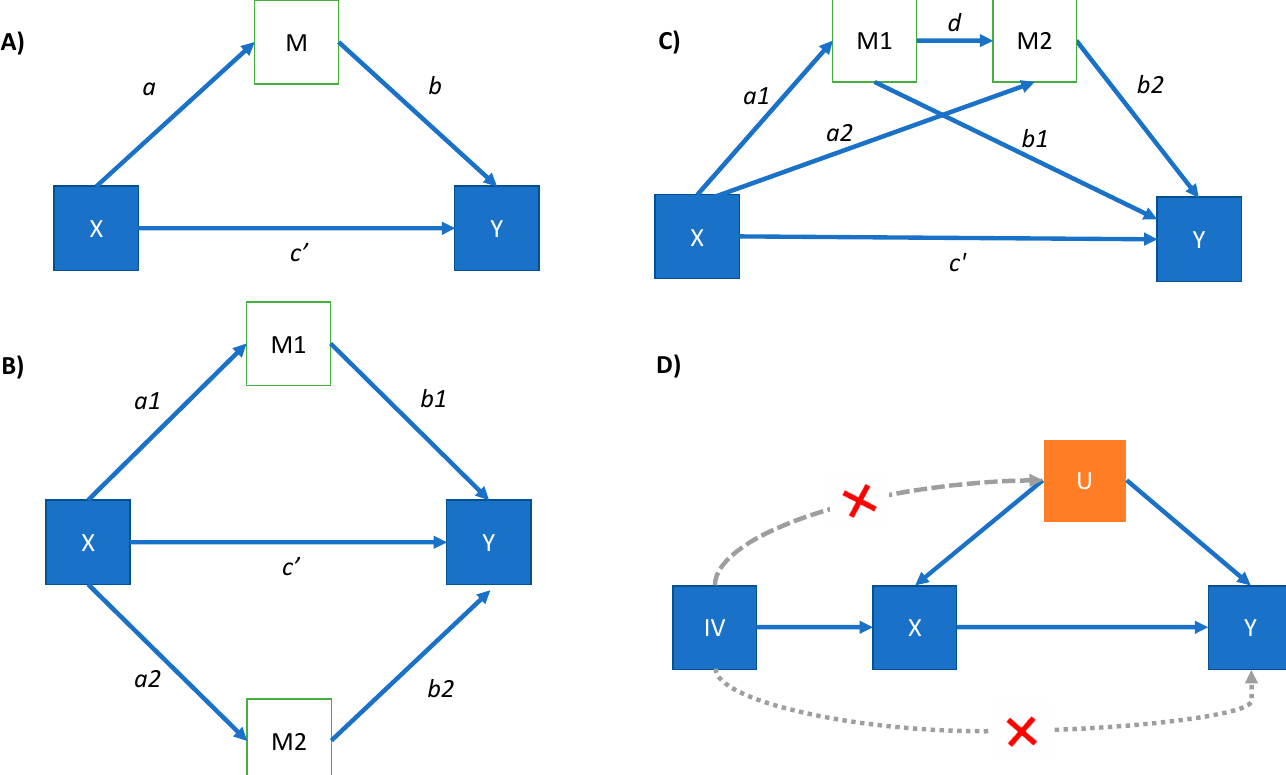
Figure 1. Hypothetical directed acyclic graph models. ( A ) Pairwise mediation model; ( B ) Parallel mediation model; ( C ) Serial mediation model; ( D ) Mendelian randomization model. X: independent variable; M: mediator; Y: outcome; IV: instrumental variable; U: confounding. SEM Pathways: a is the coefficient of the effect of X on M; a 1 and a 2 are coefficient effects between X and mediators 1 (M1) and 2 (M2), respectively. b is the effect of M on Y adjusting for the explanatory variable; b 1 and b 2 are coefficient effects between mediators 1 (M1) and 2 (M2), and Y, respectively; c’ is the coefficient of the effect of X on Y adjusting for M (direct effect), and d is the coefficient effect between mediators. For ( D ) in MR, the IV must not be related to confounders (dotted line) of the exposure–outcome association and affect the outcome only via the exposure and not through another via (dotted lines).